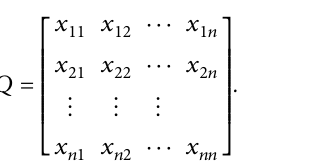
From each row of Table 1, intermediate use + final product (final use) � total output, i.e., Equation (2) as shown below: